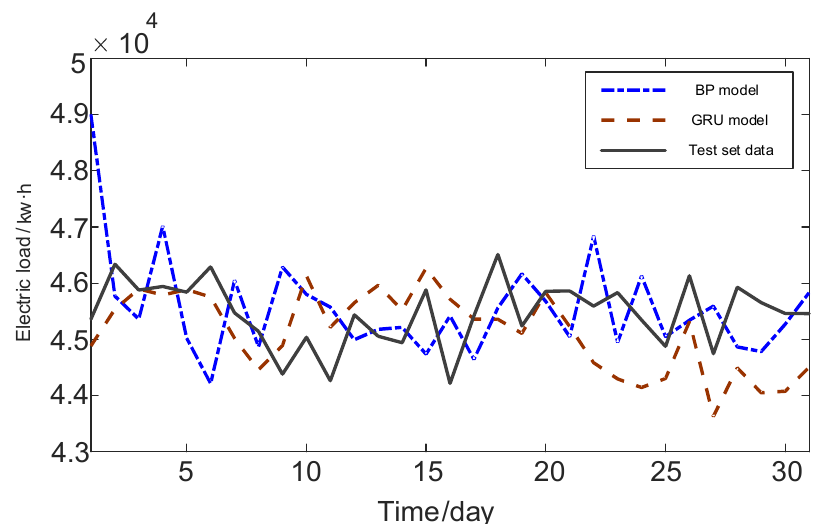
7 of 19 Table 1. Comparison of BP and GRU neural network prediction results. Time /days